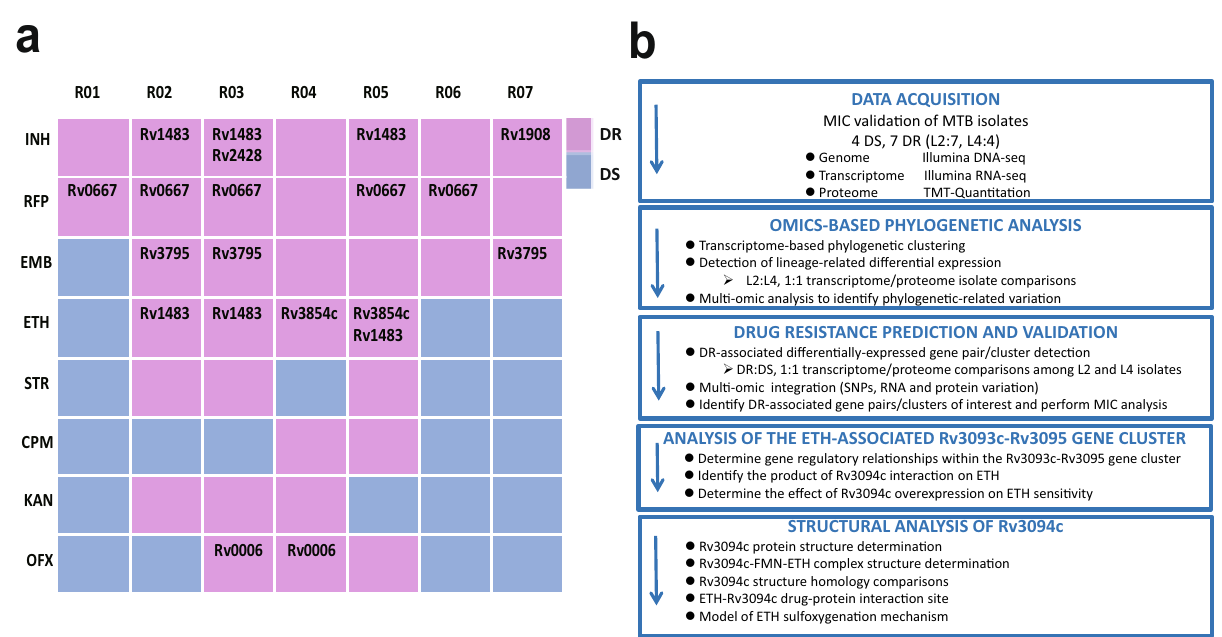
Fig. 1 Study outline and work fl ow for the analysis of 11 M. tuberculosis isolates with different drug resistance pro fi les. a Drug resistance pro fi les and SNP-containing well-established drug resistance-associated genes present in the seven drug-resistant isolates. Gene IDs are those of well-established drug resistance-associated genes containing SNPs present in the isolate. b Study outline and work fl ow (drug-sensitive: DS; drug-resistant: DR).